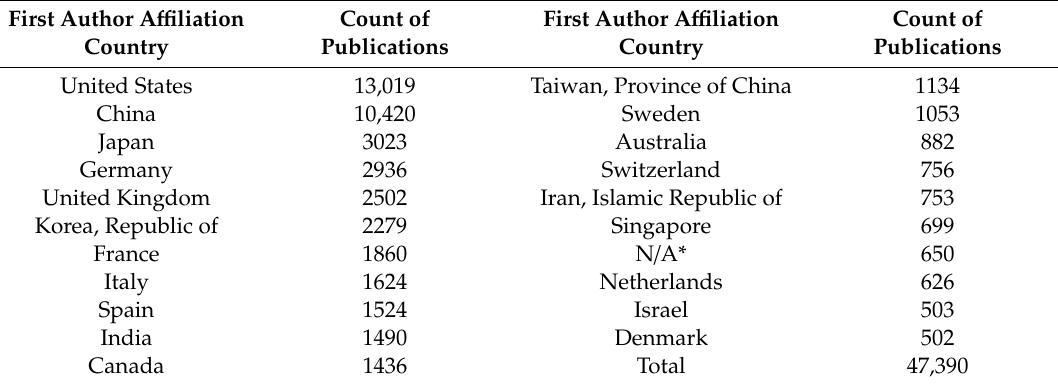
Figure 8. Place of publication (country of the source) by year. Table 2. List of the dominant countries with 500 or more publications based on the first author’s affiliation (PubMed dataset, all years).